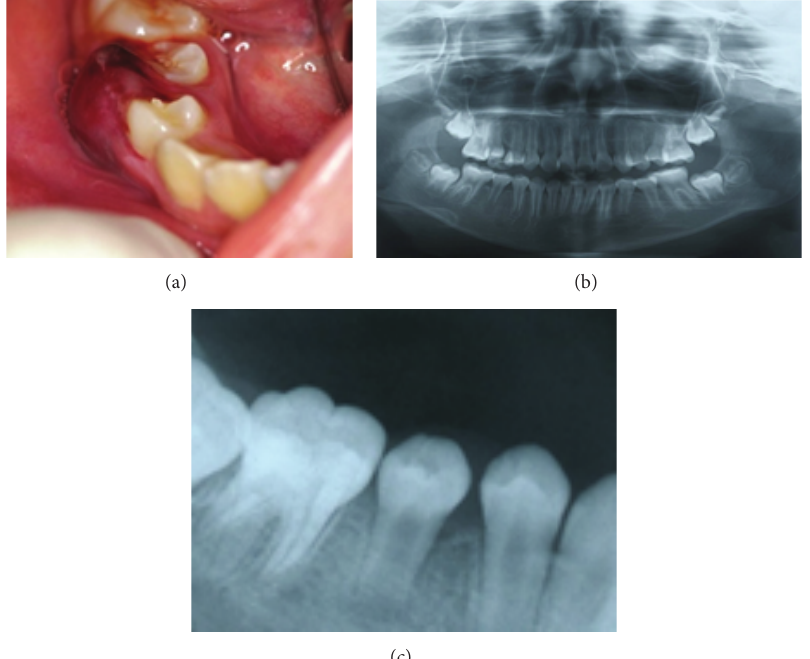
Figure 1: (a) Preoperative intraoral photograph showing a gingival abscess in the mandibular right second premolar. (b) Panoramic X-ray showing extensive radiolucency in the periradicular region in the mandibular right second premolar compared with the mandibular left second premolar. (c) X-ray showing an immature open apex and enlargement of the periodontal ligament space and extensive radiolucency in the periradicular region in the mandibular right second